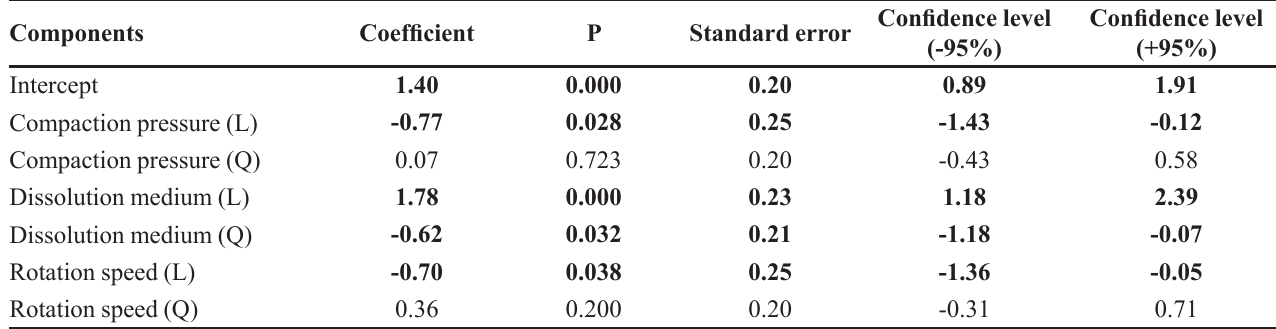
TABLE IV - Estimated regression coefficients and significance tests of linear (L) and quadratic (Q) components of the factors studied. Result is significant for p <0.05 ( bold )